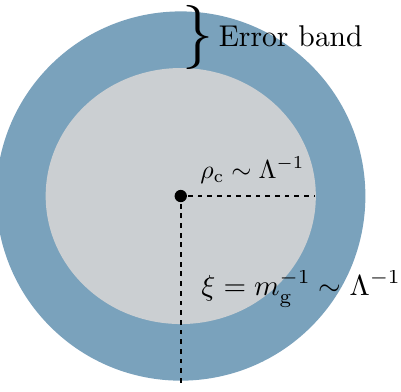
Figure 5 . This diagram depicts a source of quantitative error. We use one-loop result for strong scale, which should be reliable for ˜ l . ρ Λ − 1 and unreliable for ˜ l & ρ , where it leads to an c ∼ c IR divergence. At the same time, the proliferation of fractional vortex instantons with fugacity e − S I /N generates a finite correlation length ξ ∼ Λ − 1 . Because of the Debye screening, this cuts-off the interaction between fractional vortex instantons at distances larger than ξ ∼ ρ , essentially c removing the bad zone from integration. Depending on the numerical values of ξ ∼ ρ , there may c be a band which induce quantitative error. We then use RG arguments to find relevant operators at θ = 0 . Since RG is independent of θ , we can extrapolate our effective theory to arbitrary θ . In 1 , this gives us a gapless theory at θ = π . Despite the fact that “naive” error band becomes CP infinite, this result is reliable because the determiner of error is θ = 0 . Therefore, both gap and gaplessness are robust qualitative predictions of the